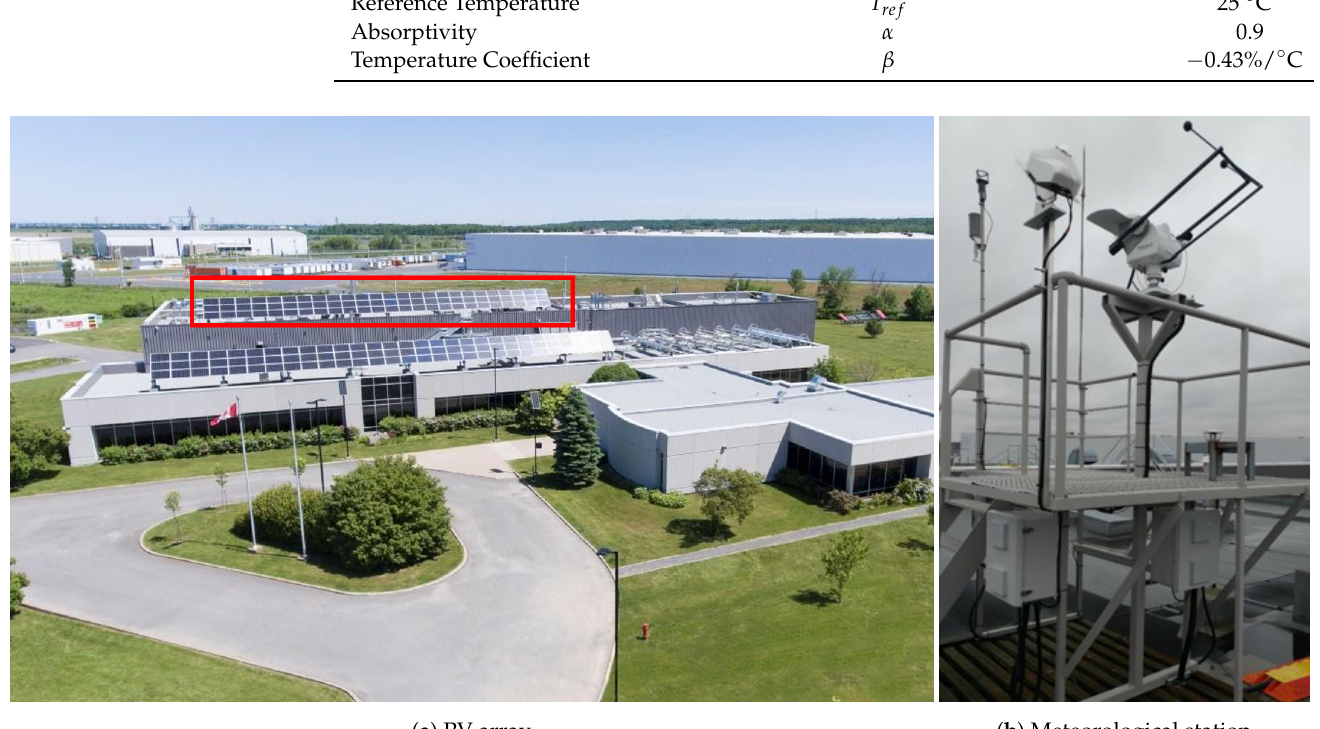
Figure 1. PV array setup at CanmetENERGY in